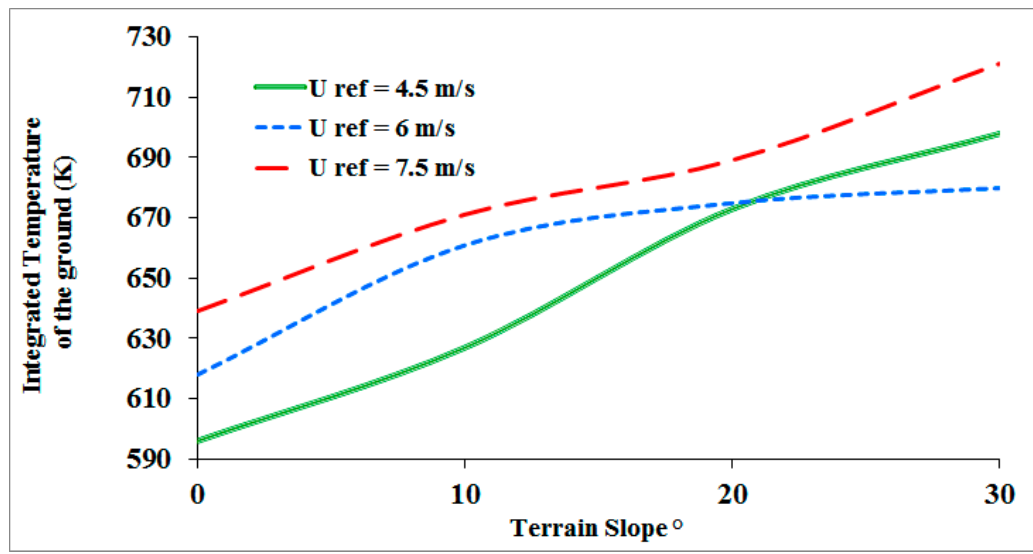
Figure 10. Integrated temperature on the ground at the considered domain for U ref = 4.5, 6, and 7.5 m/s and terrain slope 0°, 10°, 20°, and 30°.